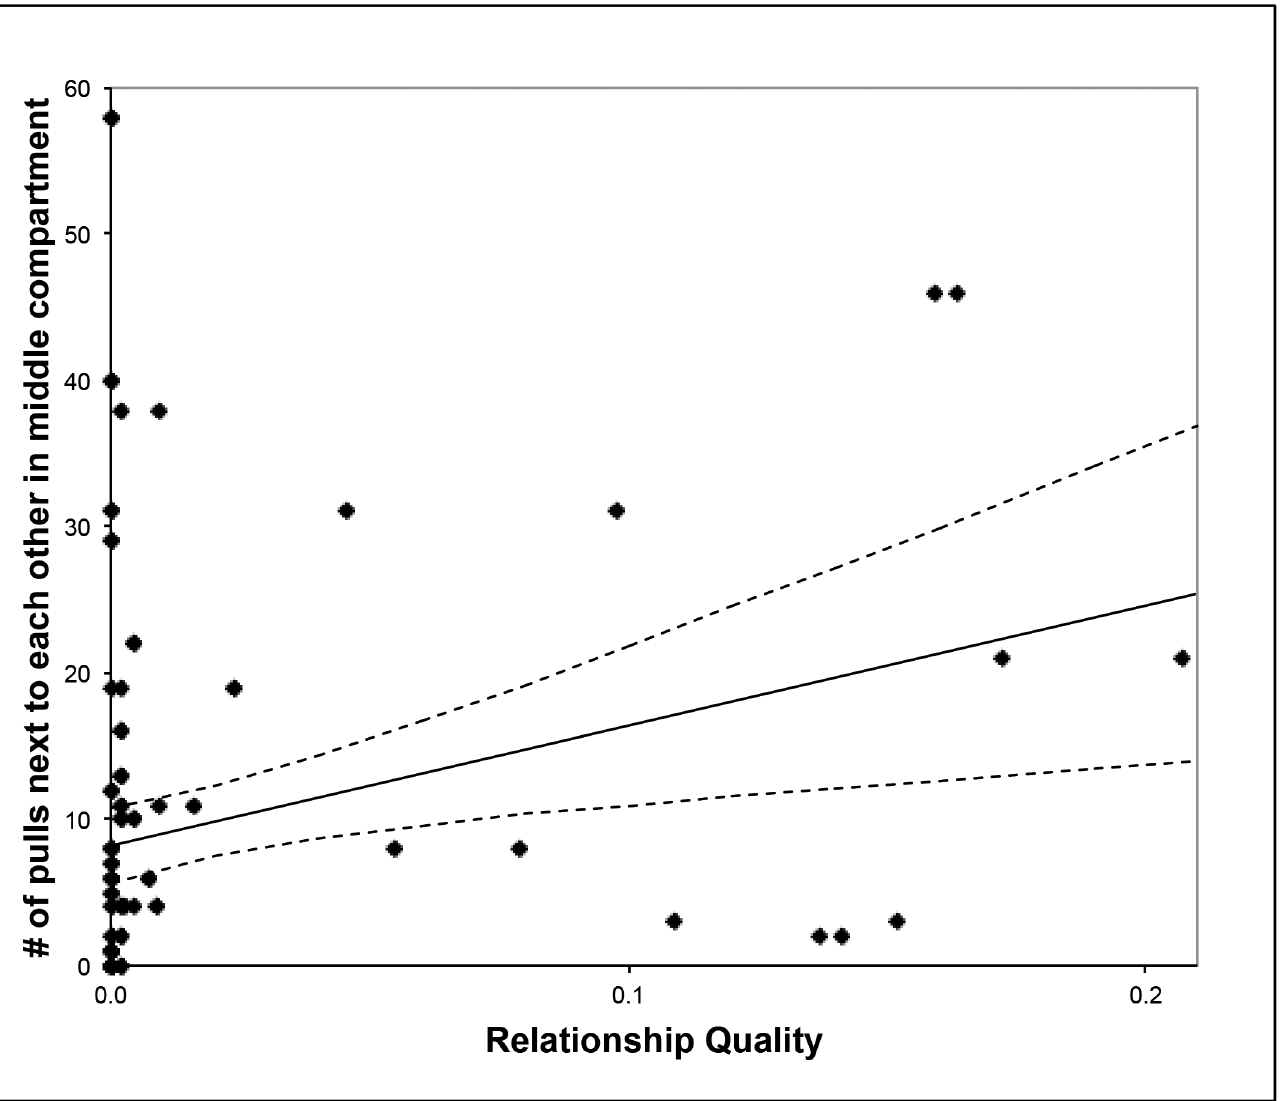
Fig 6. Relation between how often two subjects were standing next to each other in the center compartment (while cooperating with another bird) and their relationship